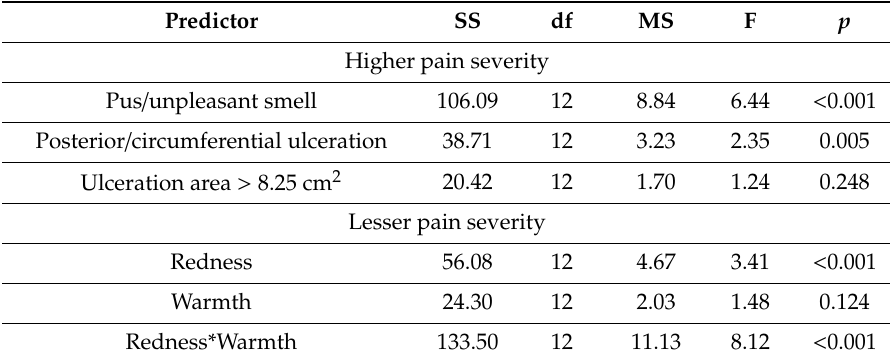
Table 4. Ulcer characteristics as the predictors of higher and lesser pain severity; the results of multivariate